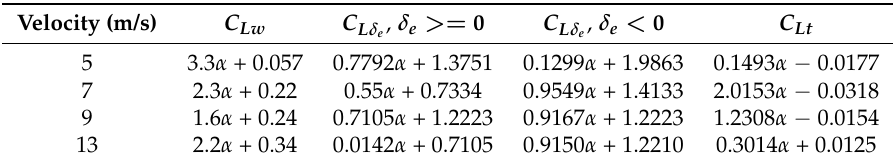
Table 6. Coefficient of lift